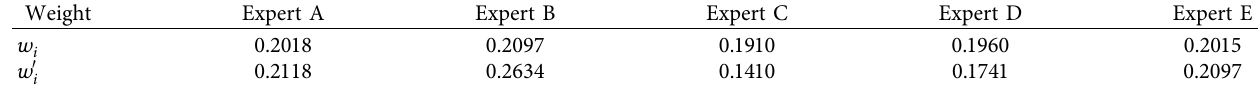
Table 5: Comparison of weight coefficients related to valuation